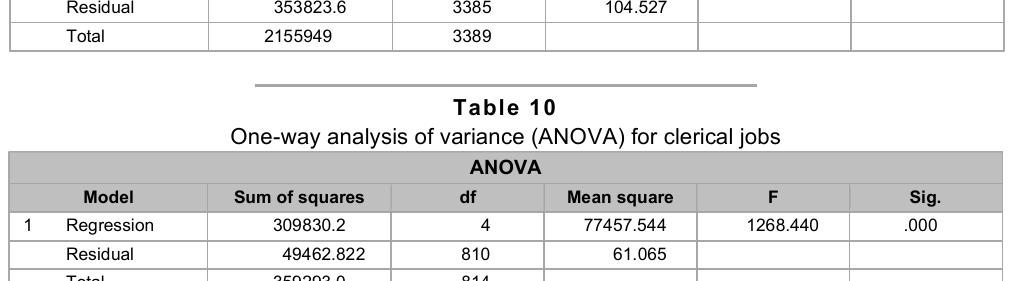
One-way analysis of variance (ANOVA) for professional jobs ANOVA df Mean square Sig.